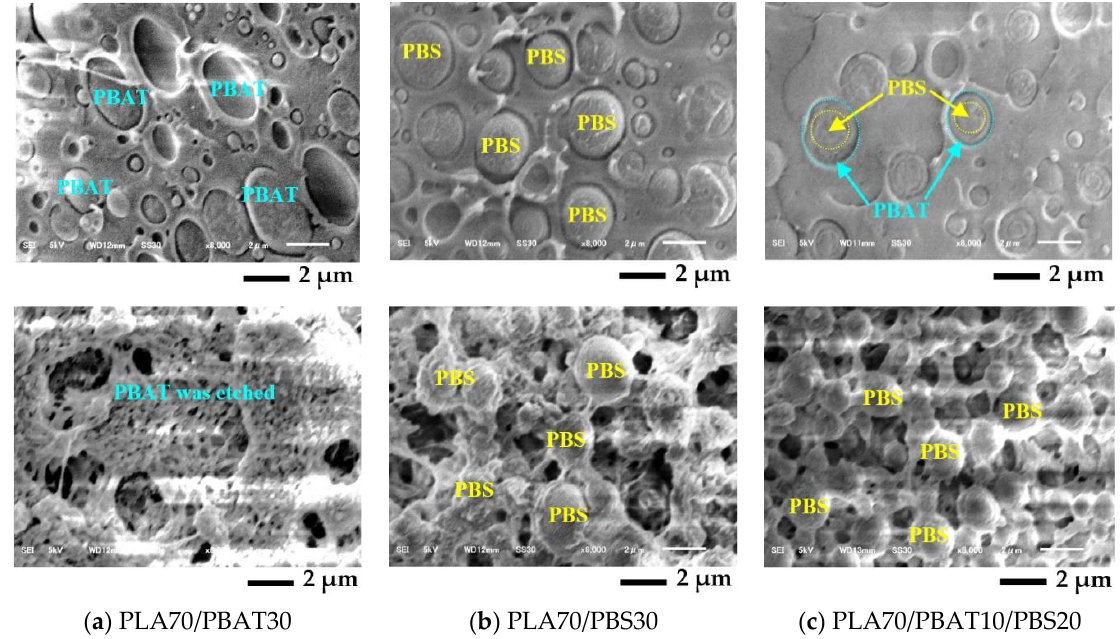
Figure 8. SEM images from the fractured surface of compression-molding binary and ternary blends PLA/PBAT/PBS without nano talc: ( a ) PLA70/PBAT30; ( b ) PLA70/PBS30; ( c ) PLA70/PBAT10/PBS20 (the SEM images in the top row and bottom row are the fractured surface before and after etching PBAT, respectively).